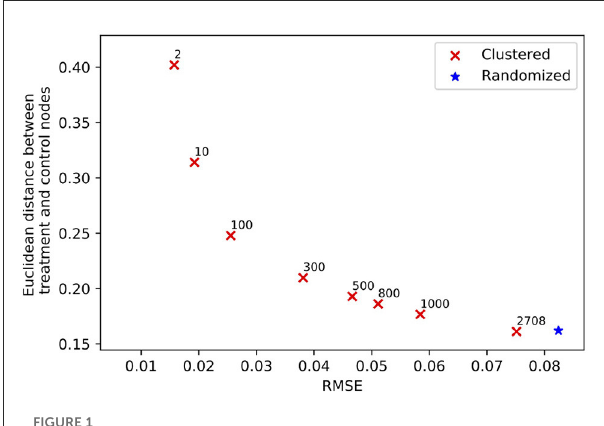
FIGURE1 The tradeoff between selection bias (distance) and undesired spillover (RMSE) in cluster-based randomization; each data point is annotated with the number of